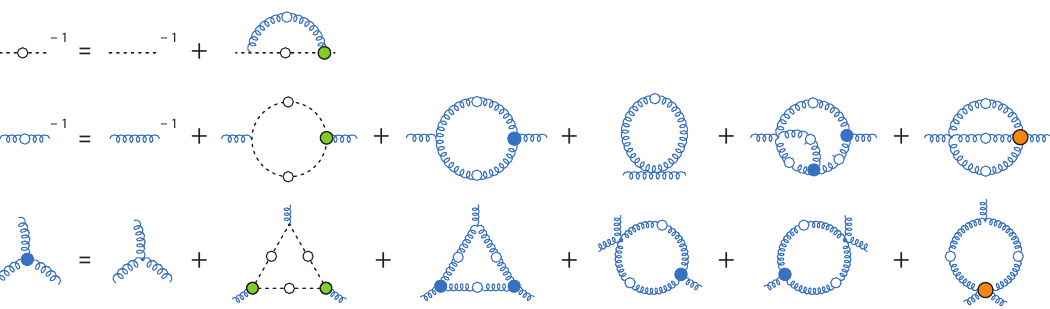
Figure 2: Coupled Yang-Mills DSEs for the ghost propagator, gluon propagator and three-gluon